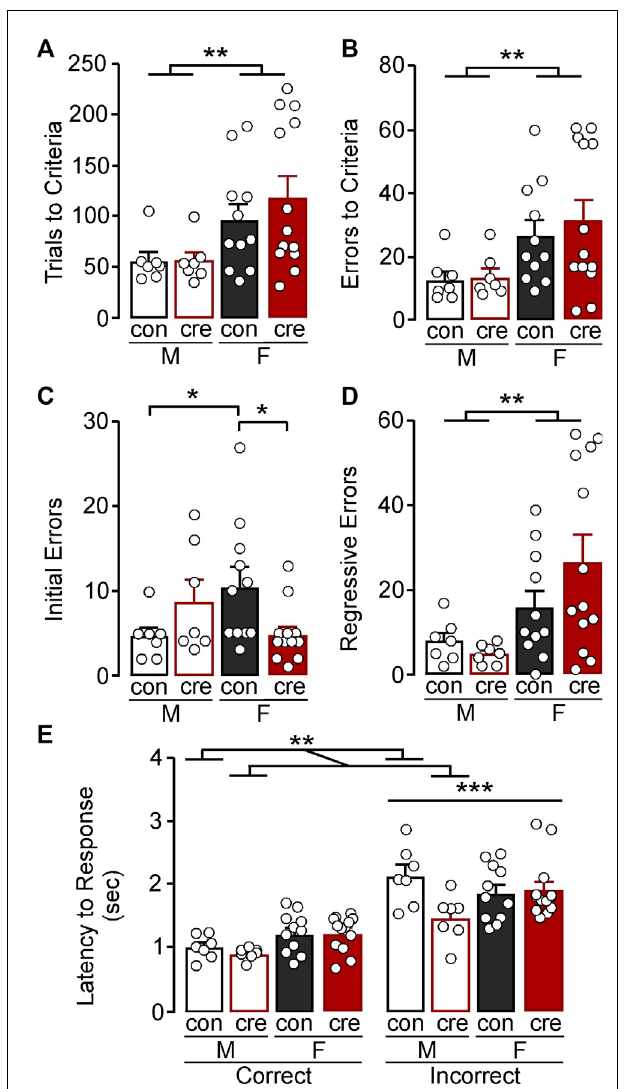
FIGURE 2 | Visual cue test. (A) Females took more trials to reach the criterion compared to males (** p < 0.01). (B) Females made more errors to reach criterion compared to males (** p < 0.01). (C) Female control mice made more initial errors compared to male control mice while female cre-positive made fewer errors compared to female control mice (* p < 0.05). (D) Females made more regressive errors compared to males (** p <